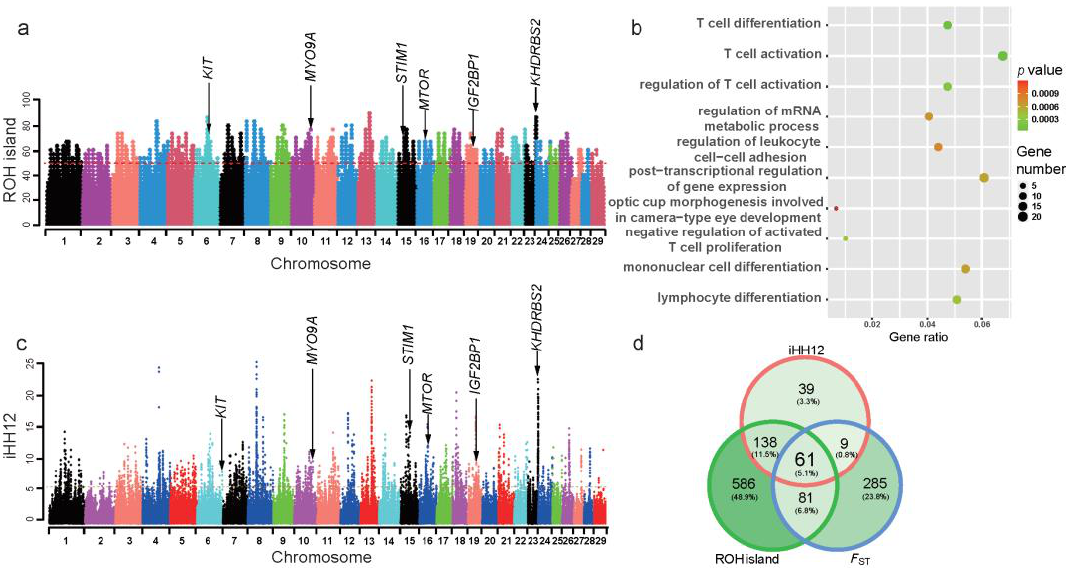
Figure 4. Genome-wide detection of ROH islands and selection signals in JC goats. ( a ) Manhattan plot of the genome-wide frequency of SNPs occurrence into ROHs in JC goats. The red line indicates that the SNPs in ROHs were shared by more than 50% of the animals, which was used to define ROH islands. ( b ) The top 10 enriched GO biological processes for the genes overlapping with ROH islands. ( c ) Manhattan plot of genome-wide iHH12 across all 29 autosomes in JC goats. The dashed line represents a threshold of the top 0.5% of outlier windows. ( d ) Venn diagram for the positively selected genes identified via three approaches .